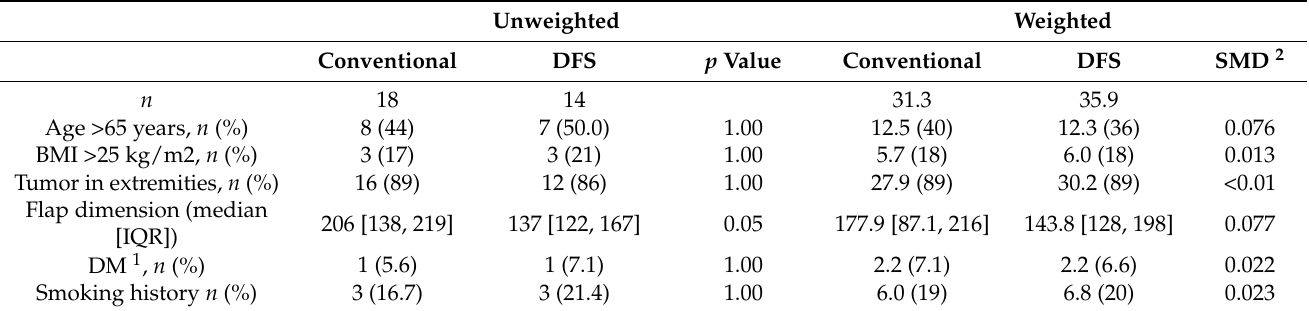
Table 1. Demographics of unweighted population and weighted pseudo-population. Unweighted